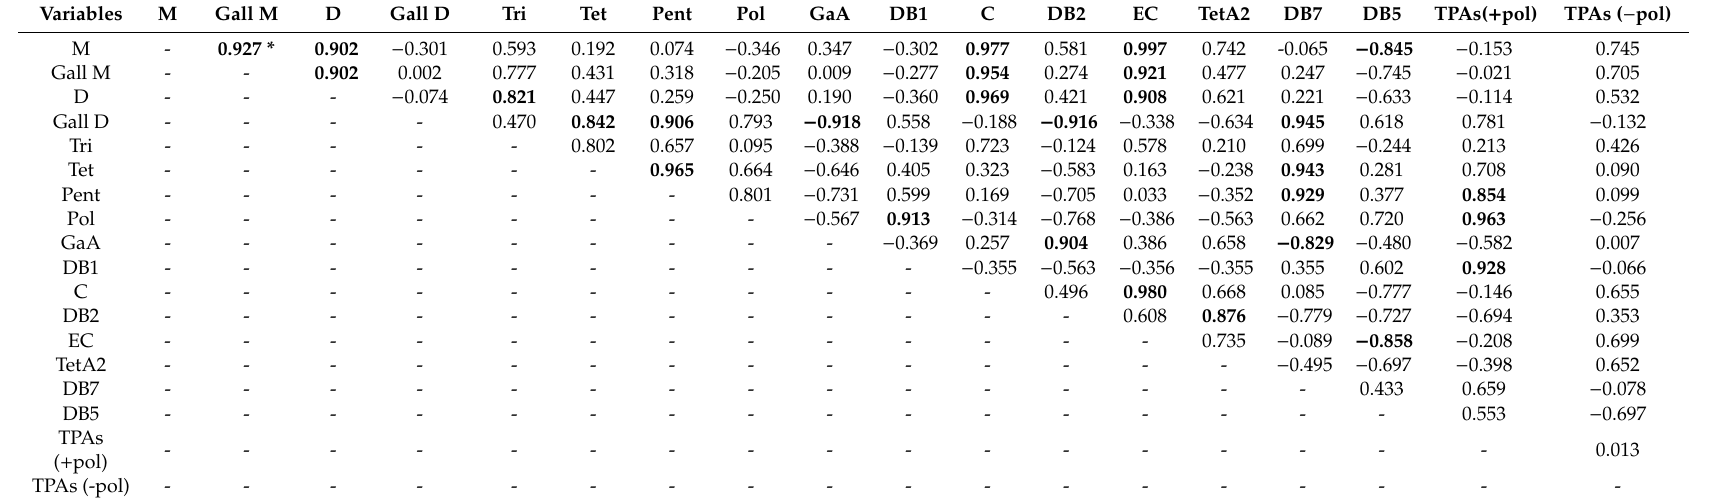
Table 5. Matrix of correlation coe ffi cients ( r ) of variables based on proanthocyanidins content (%, fresh weight) in the seed in black ‘Isabel’ grape during berry